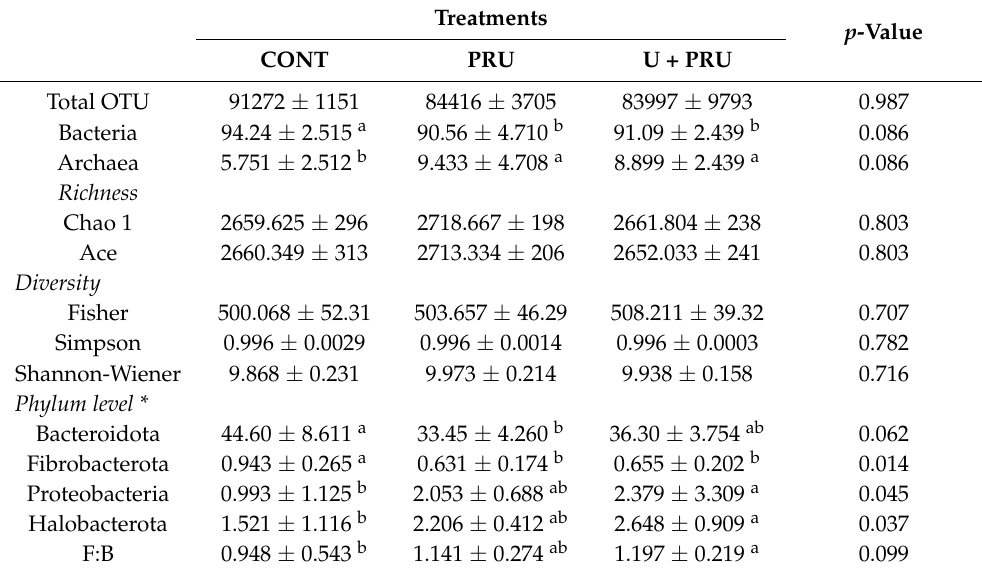
Table 6. Median and interquartile range of total operational taxonomic units (OTU), Bacteria, Archaea, richness index, diversity estimators, and phylum level in Nellore steers supplemented with post- ruminal urea and conventional urea during the dry